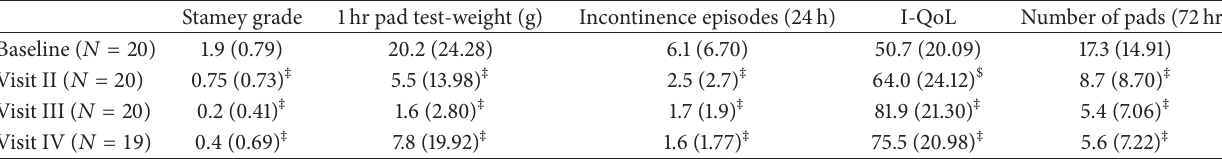
Table 1: Efficacy outcomes versus baseline (visit I) characteristics after 6 weeks (visit II), 3 months (visit III), and 12 months (visit IV).